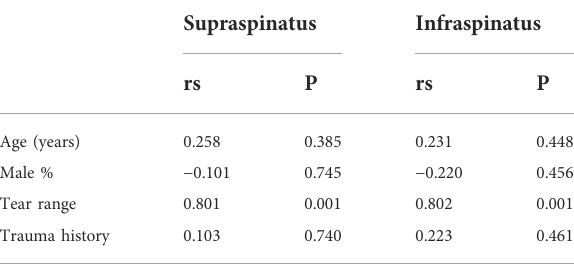
TABLE 5 Correlation analysis of the average Goutallier grade of supraspinatus and infraspinatus in the complete tear